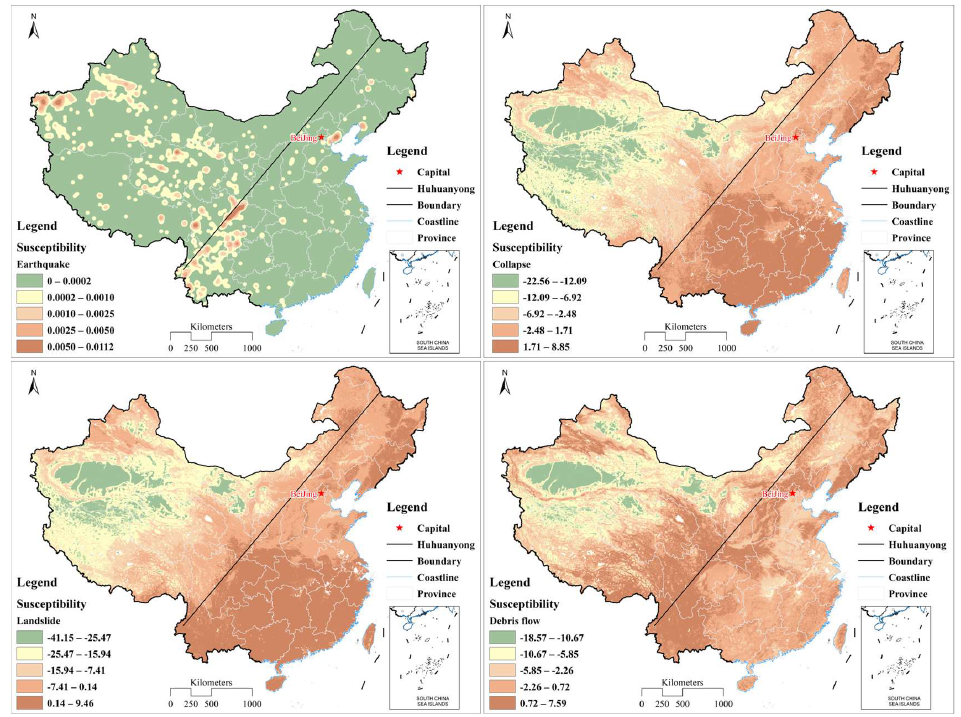
Figure 9. Evaluation Analysis of Susceptibility to a Single Geological Hazard.